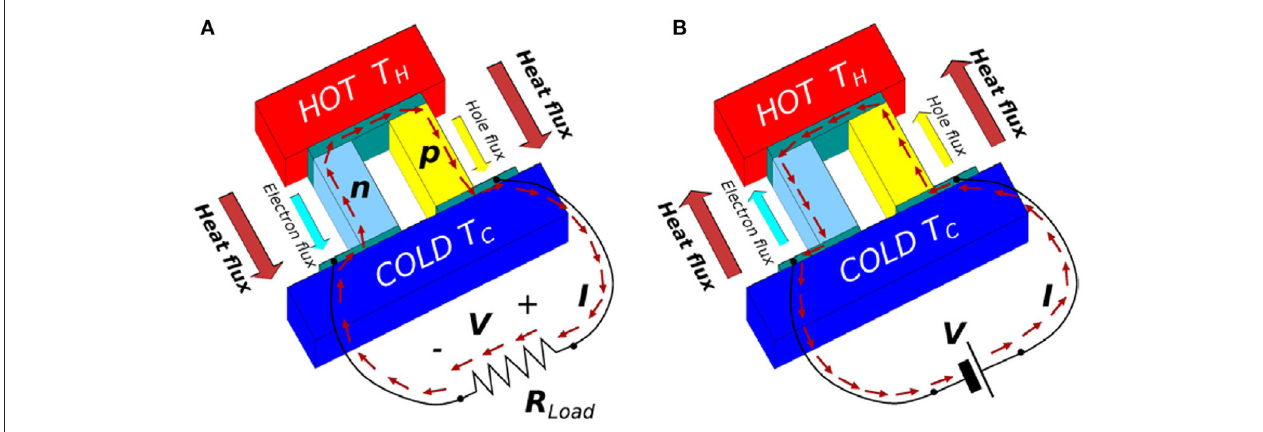
FIGURE 1 | Sketch of thermoelectric device: (A) Thermoelectric generator; (B) Thermoelectric cooler. Reprint with permission from Pennelli (2014). Copyright 2014 Journal of